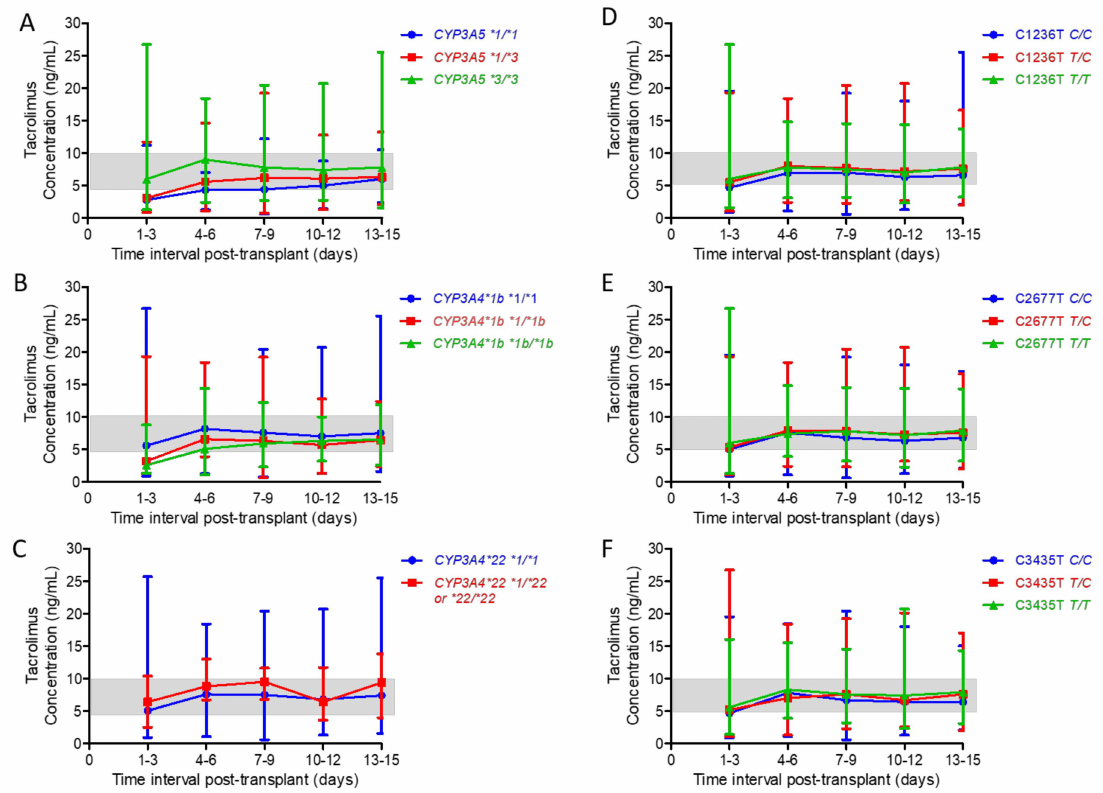
Figure 3. Median steady-state tacrolimus trough concentrations during the first 15 days post-transplant for CYP3A4 / 5 and ABCB1 SNPs. Associations between steady-state tacrolimus trough concentrations measured in 3-day intervals and CYP3A4 / 5 ( A – C ) and ABCB1 ( D – F ) SNPs were evaluated. The x-axis denotes time in 3-day intervals for the first 15 days post-transplant while the y-axis represents the median tacrolimus trough concentrations. The shaded area represents the goal tacrolimus trough concentration (5–10 ng / mL). Abbreviations: ABCB1, ATP-binding cassette B1; CYP3A4 / 5, cytochrome P450 isoforms 4 and 5; SNP, single nucleotide